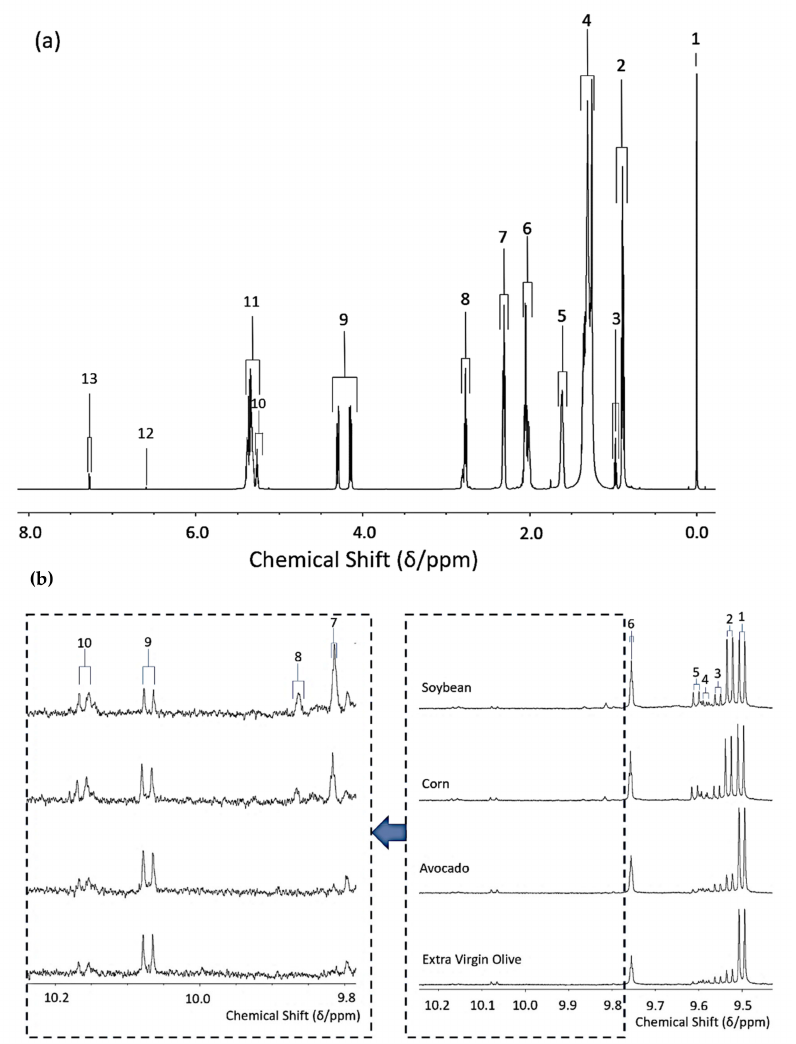
Figure 1. ( a ) Typical complete 600 MHz 1 H NMR spectrum acquired on soybean oil prior to exposure to LSSFEs, showing the major lipidic acyl chain group resonances; associated chemical shift values, multiplicities and assignments of resonances therein are detailed in Table 1. ( b ) 600 MHz 1 H NMR spectra highlighting the expanded aldehydic region (9.40–10.30 ppm) with typical spectra acquired on soybean, corn, avocado and olive oil samples after exposure to a LSSFE for a 90 min period at 180 ◦ C; also shown are the expanded 9.76–10.30 ppm regions of these spectra (numerical labels correspond to the assignments available in Table 3, as reported in